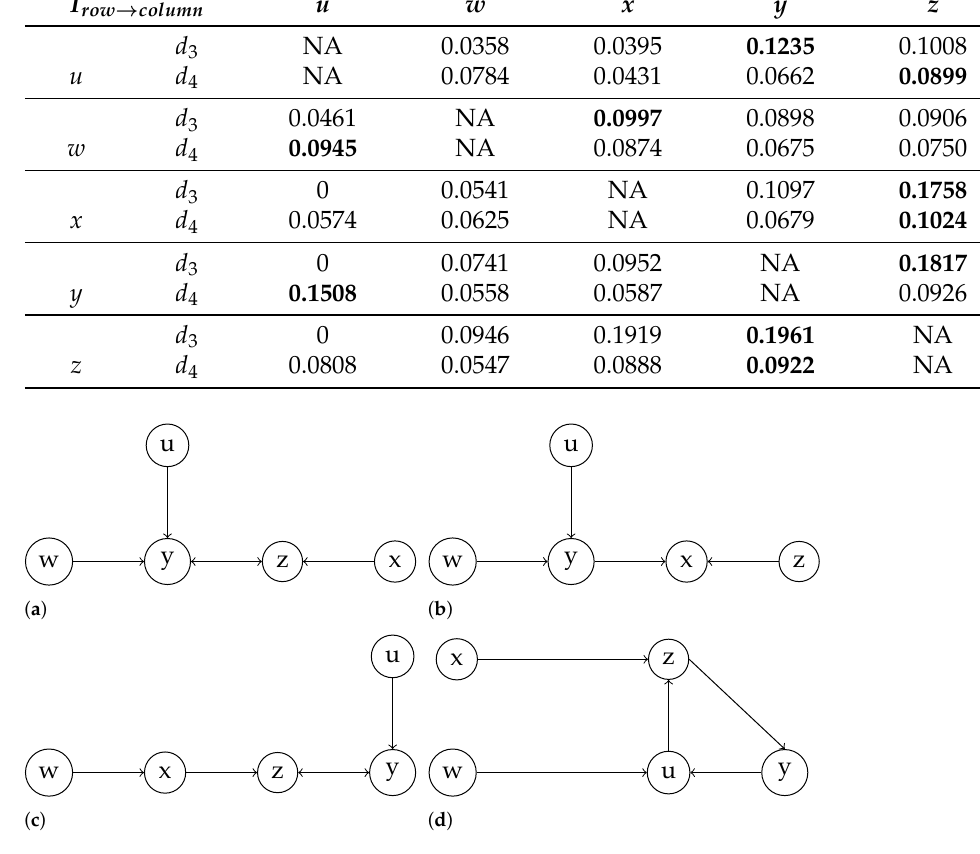
Figure 15. Causality diagrams for the 2nd variant: ( a , b ) reflect n = 50; ( c , d ) reflect n =